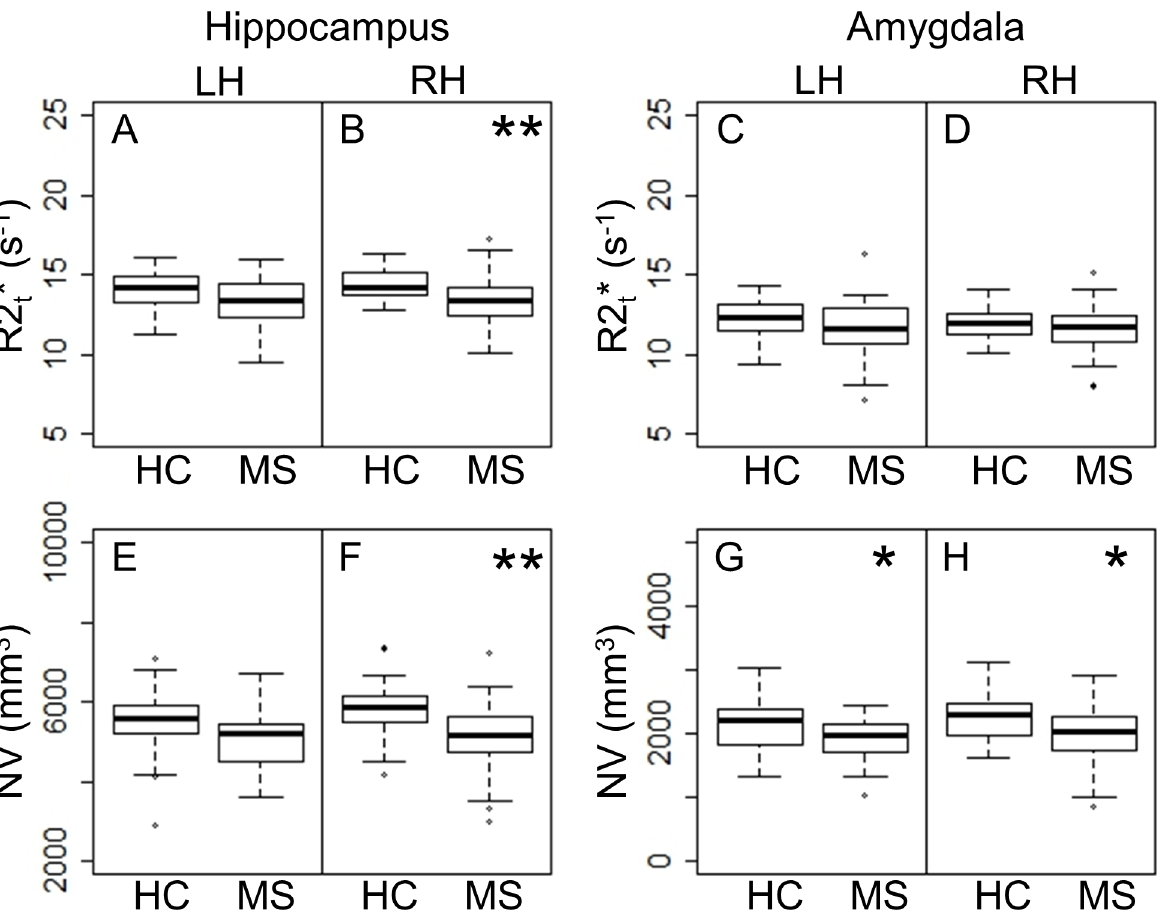
Fig 3. HC versus MS group comparisons of R2t * (A–D) and NV (E–H) of hippocampus and amygdala for each hemisphere. Panels with p-values (with FDR correction) (cid:20) 0.05 and > 0.01 are marked with “ * ”. Panels with p-values (with FDR correction) (cid:20) 0.01 are marked with “ ** ”. LH = Left Hemisphere;RH = Right